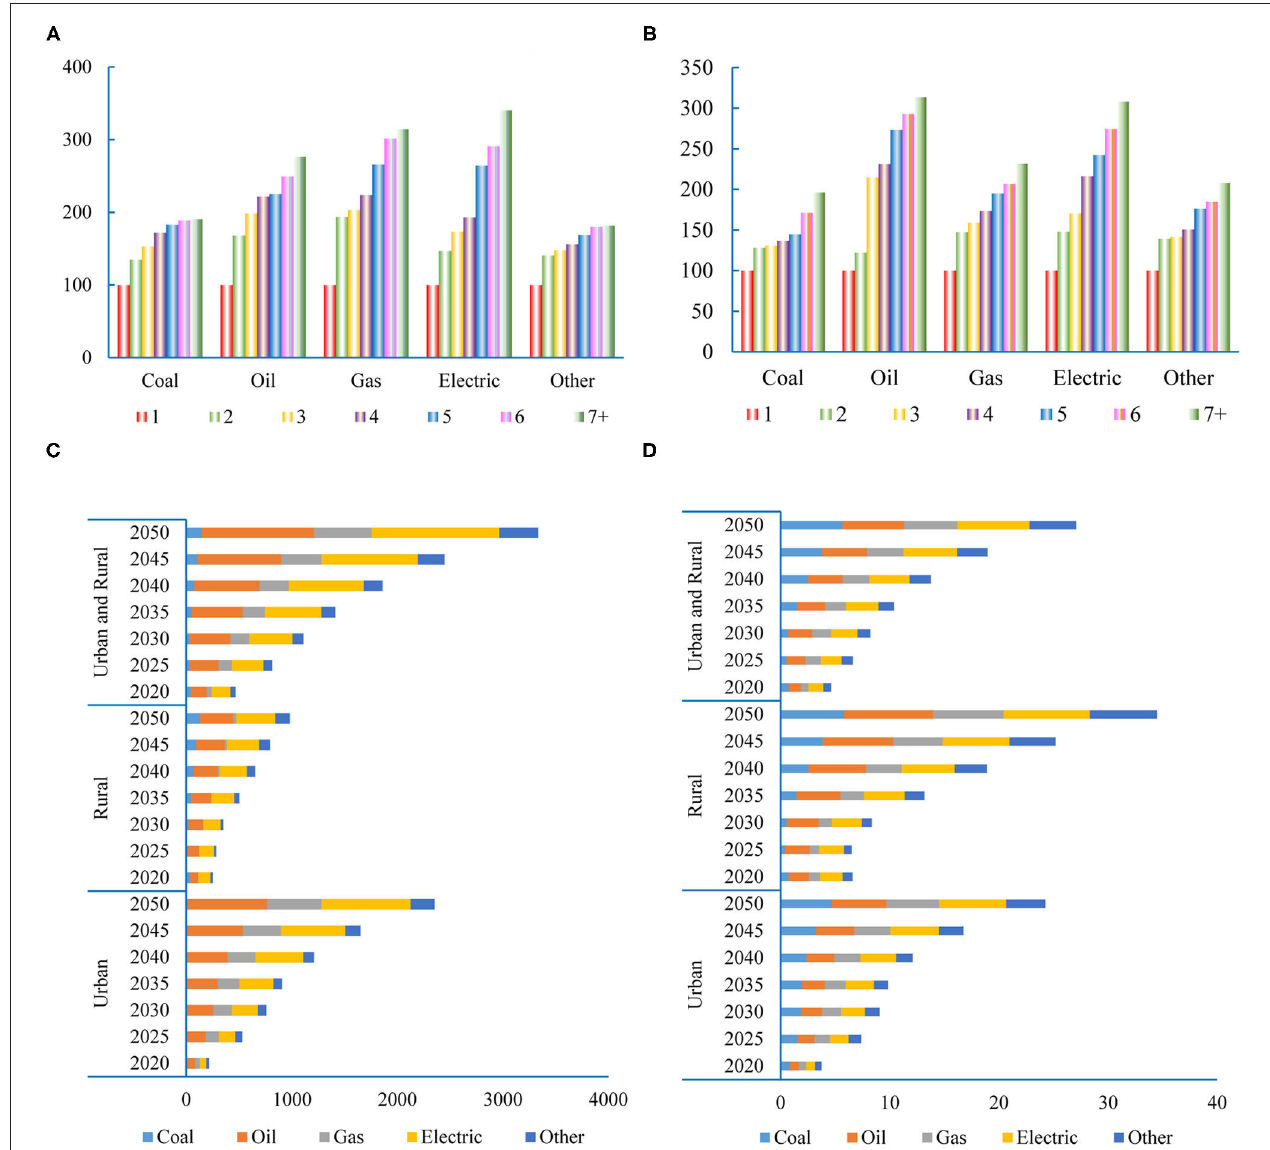
FIGURE 4 | Impact of the two-child policy on residential energy consumption (REC). (A) Energy consumption index for different household types (urban,one person household = 100). (B) Energy consumption index for different household types(rural, one person household = 100). (C) The increase of energy consumption caused by the two-child policy (Mtce). (D) The rate of energy consumtipn change caused by the two-child policy (%).